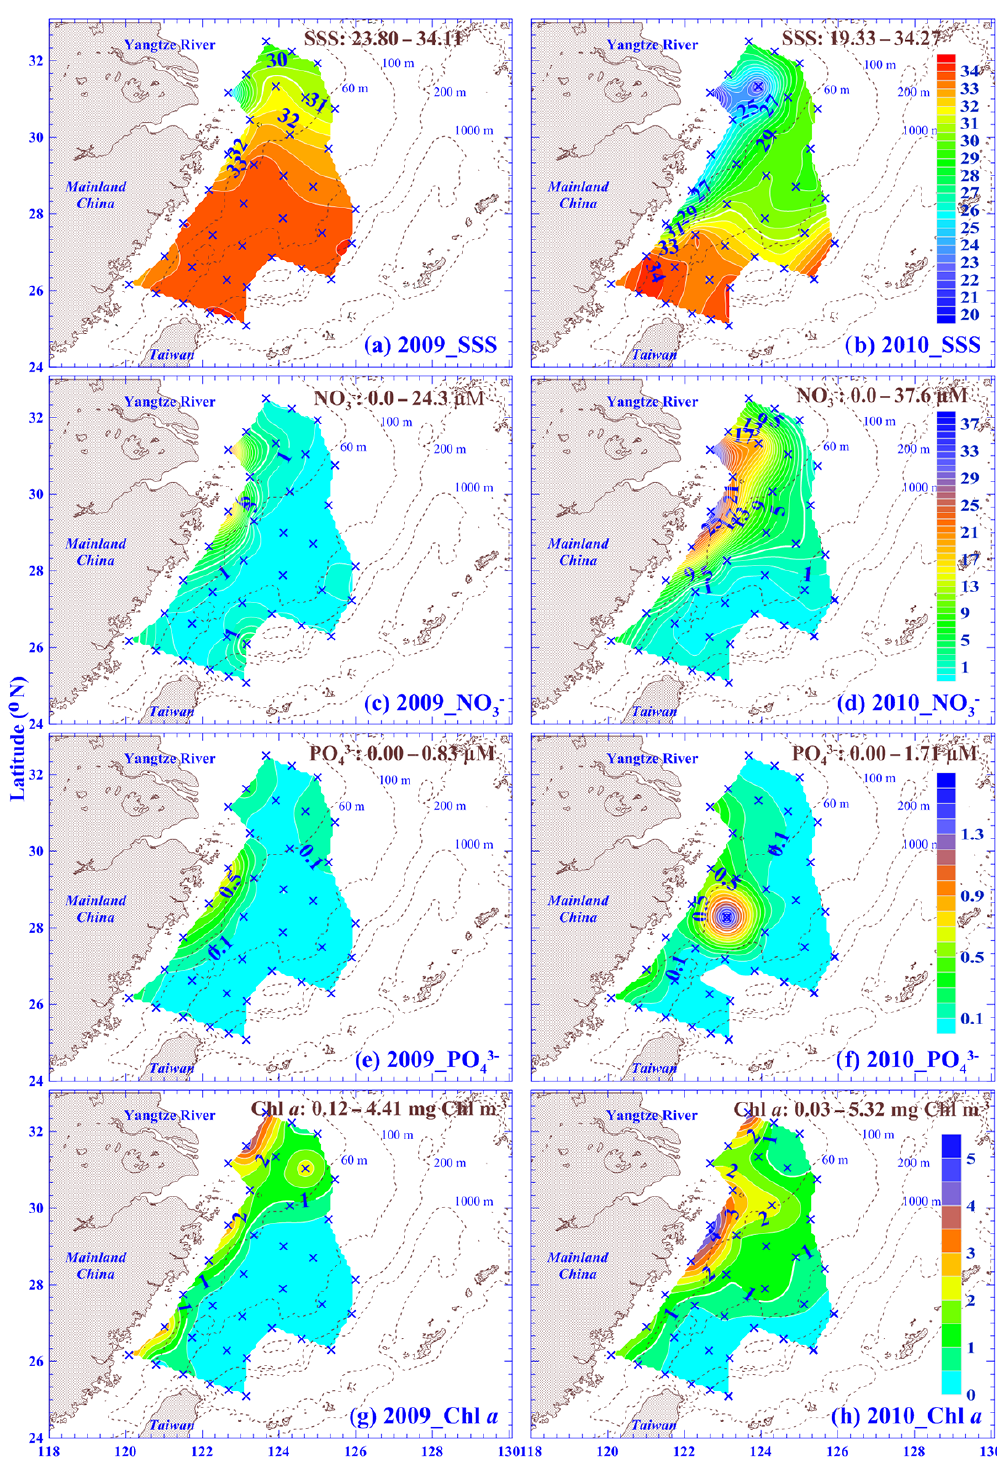
) , phosphate (PO 3 − ) , and chlorophyll a (Chl a) in the surface 3 4